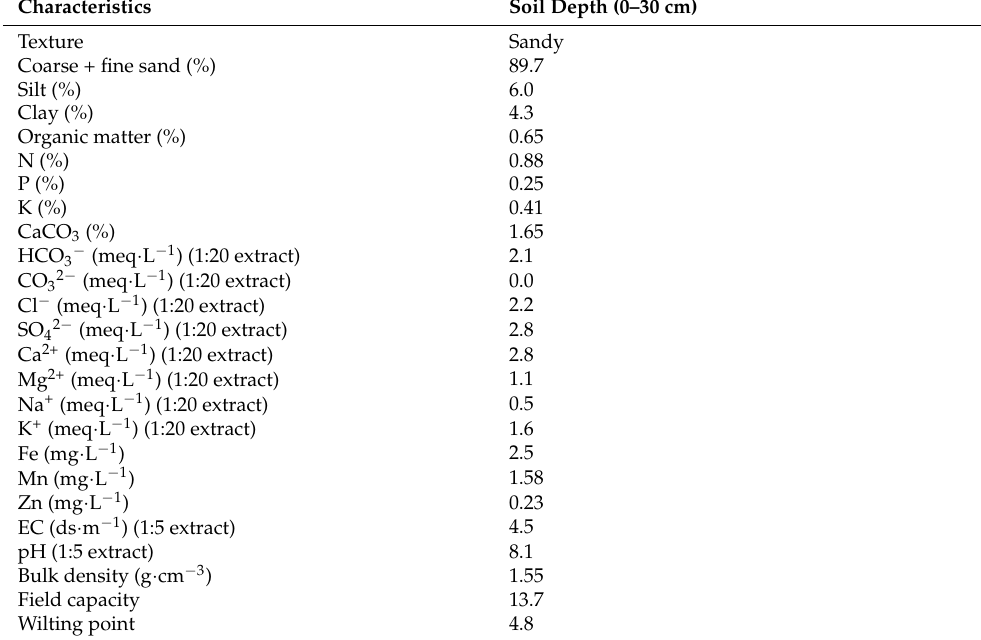
Table 5. Soil analysis of the experimental site at El-Khatatba, Menoufia, Egypt as the average of the 2018/2019 and 2019/2020